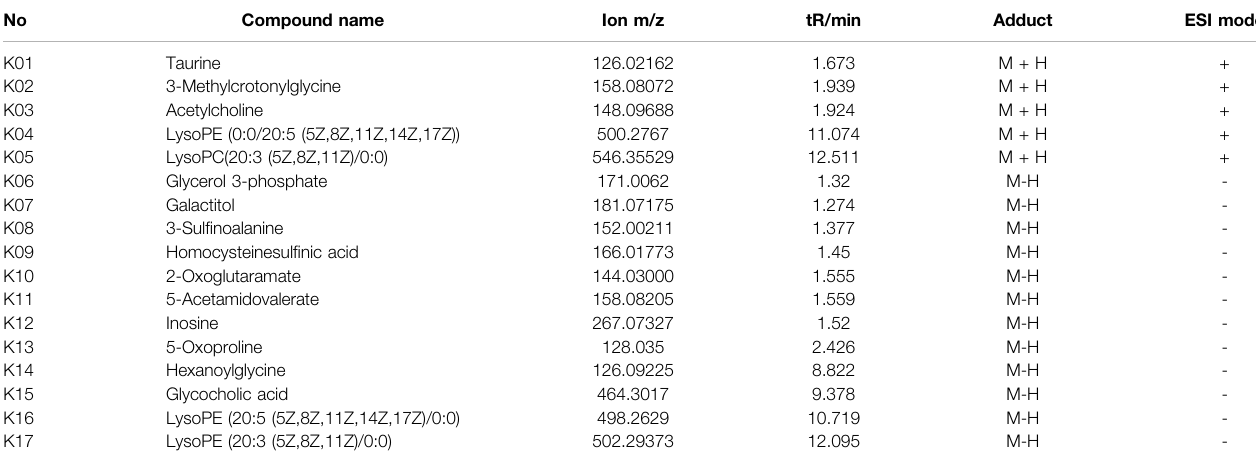
TABLE 3 | Seventeen potential biomarkers in kidney samples of